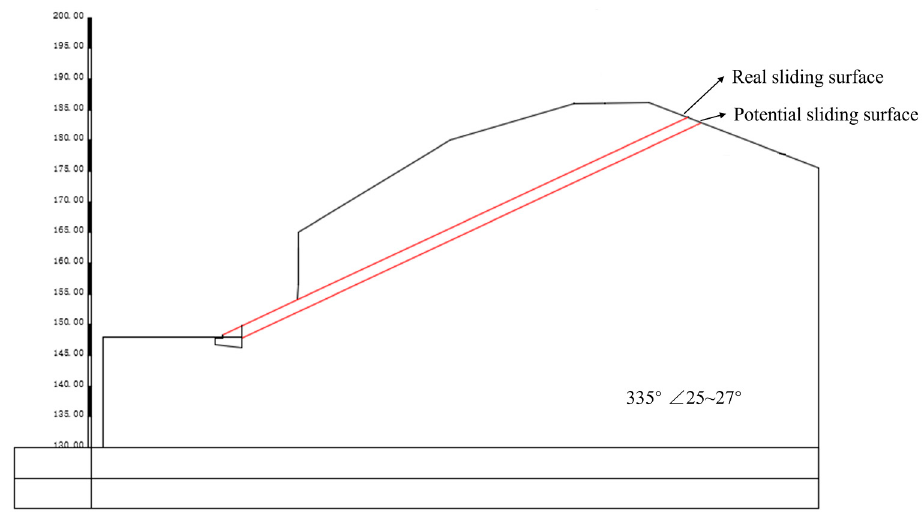
Figure 5. CAD schematic diagram of slope section.